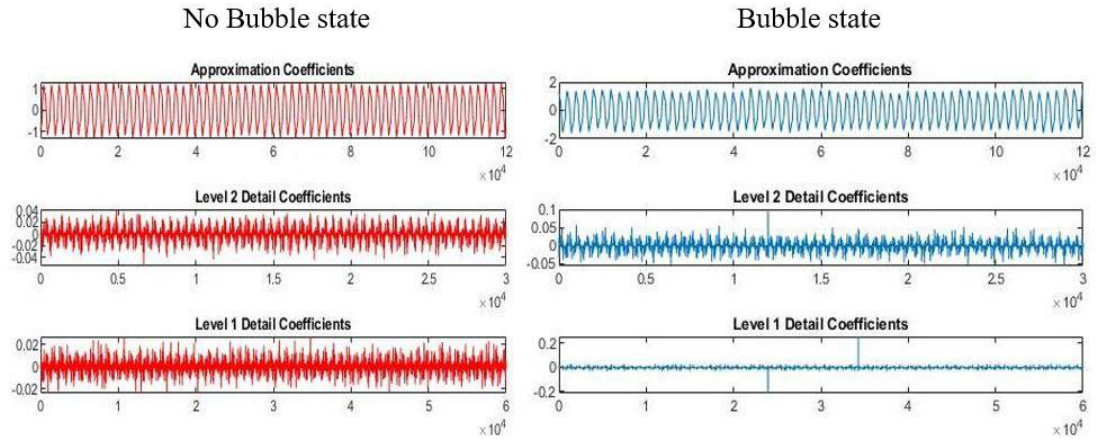
Figure 5. Comparison of training and test data in terms of accuracy in wavelet_1DCNN.